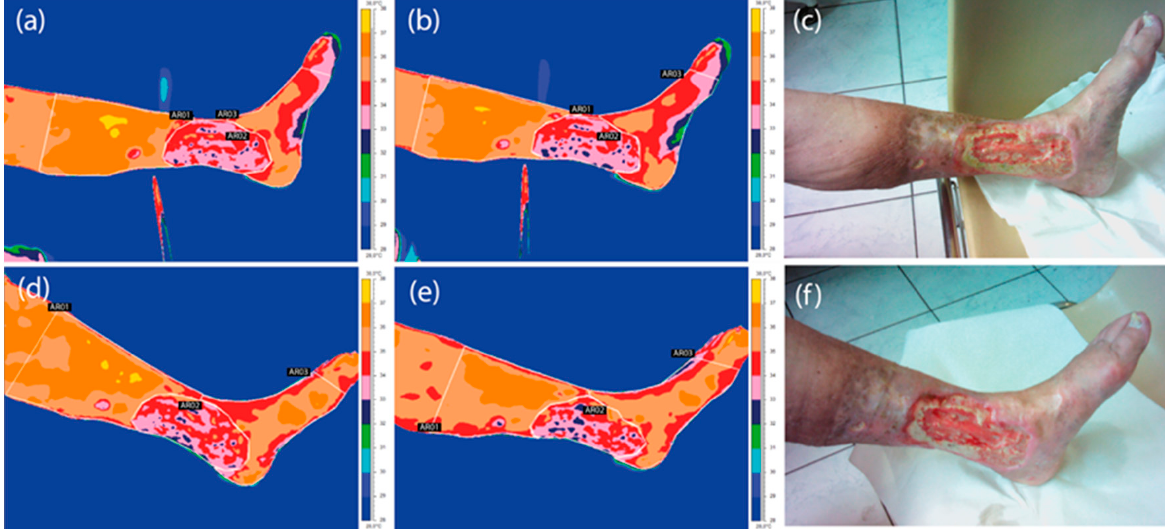
Figure 2. Thermal images of a representative patient suffering from a hard-to-heal wound taken in the 1st ( a – c ) and 3rd ( d – f ) period of treatment before ( a , d ) and after ( b , e ) THBOT with corresponding digital photos of the crura.